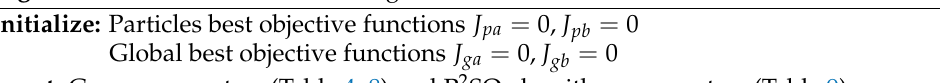
Algorithm 1 Pseudocode of P 2 SO